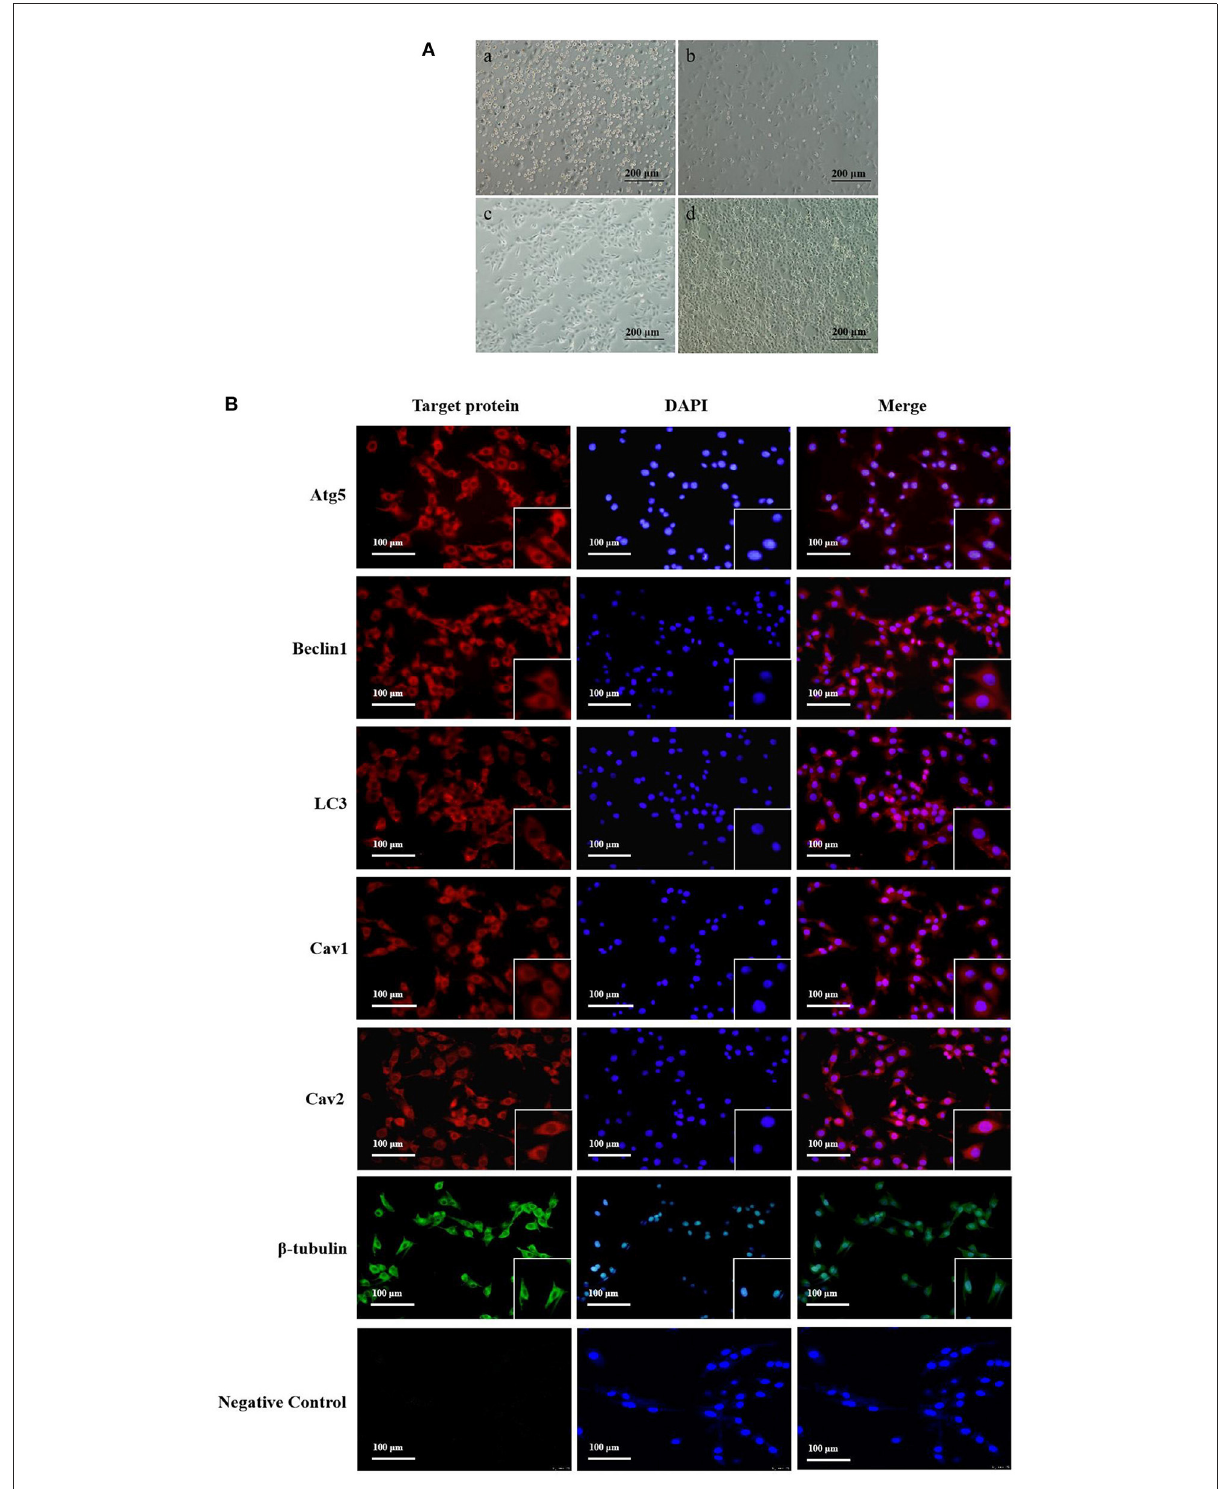
FIGURE1 Yak cumulus cells culture and distribution of Atg5, Beclin1, LC3, Cav1, Cav2 protein in CCs. (A) The growth pattern of the second generation yak cumulus cells (10 × ) (a–d showed cell growth at 6, 24, 48, and 72h, respectively). (B) Localization of target proteins in yak cumulus cells. Red fluorescence, Atg5, Beclin1, LC3, Cav1, and Cav2 protein, respectively; Green fluorescence, β -tubulin protein; Blue fluorescence: cell